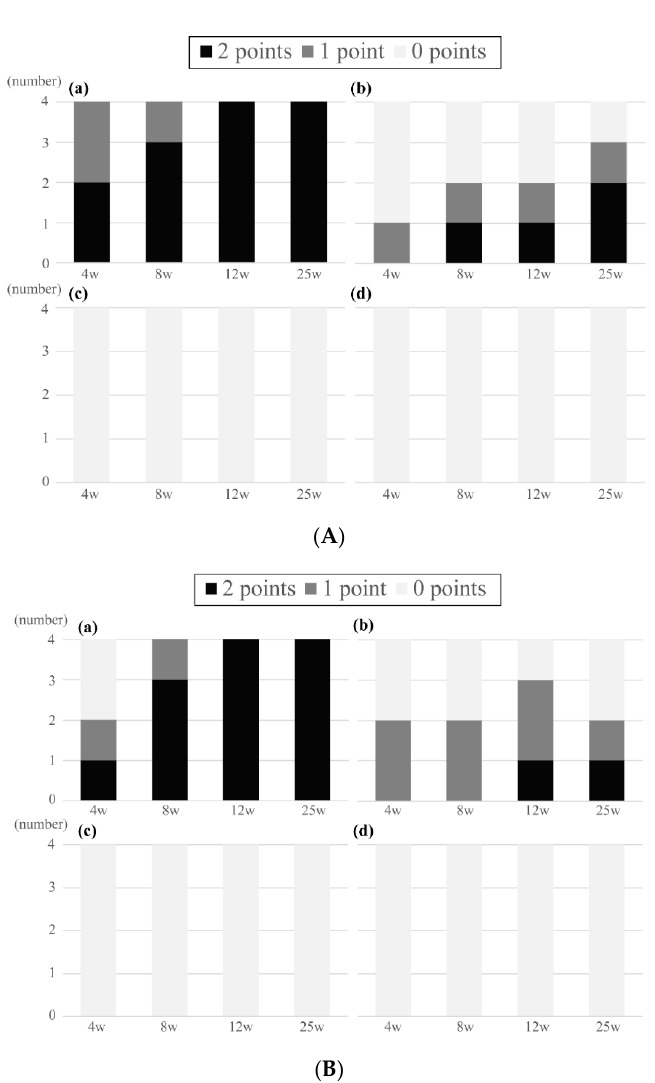
Figure 5. Histological results of bone bridging above the threaded pins of ( A ) 2.0 mm and ( B ) 4.5 mm diameter. ( A ) Diameter 2.0 mm. Depth: 1 (a) and 0 (b) mm. Protrusion: 1 (c) and 2 (d) mm. (a) Bone bridging was complete above all implants by 12 weeks. (b) At 25 weeks, two pins were completely covered by the new bone, and one had possible bone bridging. (c, d) Bone bridging was absent at all time points. ( B ) Diameter 4.5 mm. Depth: 1 (a) and 0 (b) mm. Protrusion: 1 (c) and 2 (d) mm. (a) Bone bridging was complete above all implants by 12 weeks. (b) At 12 weeks, one pin